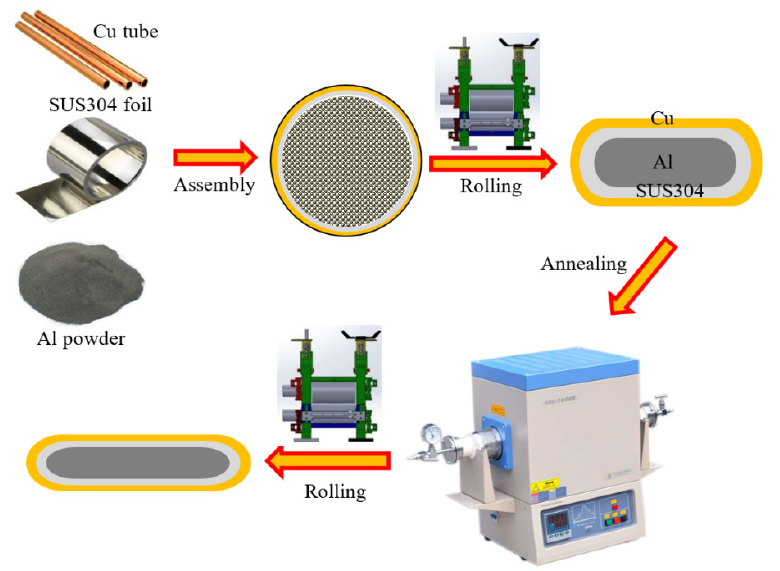
Figure 1. Schematic illustration of the preparation process of Cu/Al clad sheets with SUS304 inter- layer.